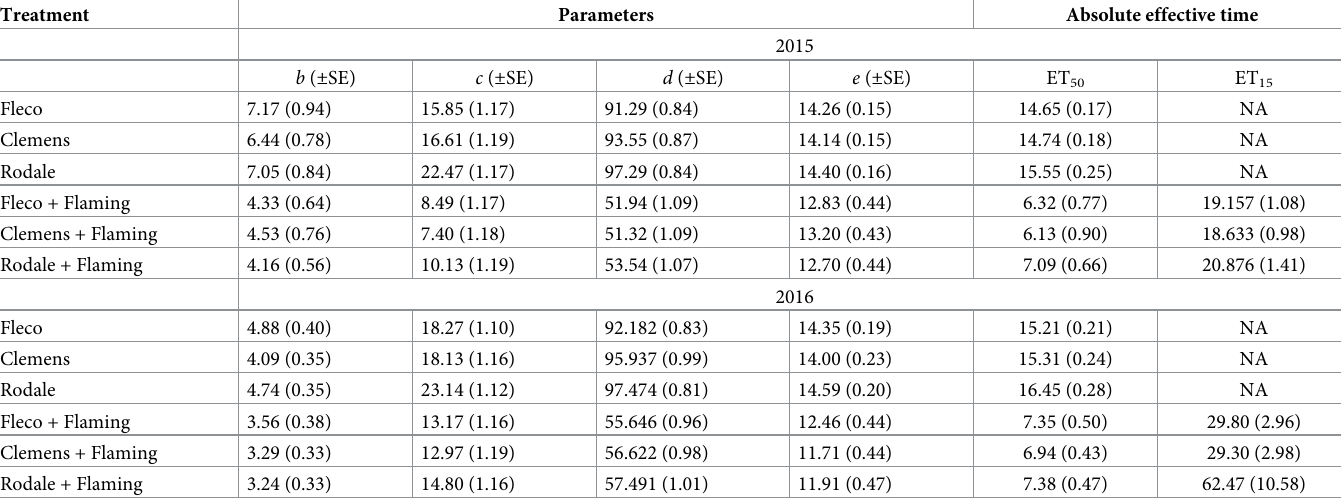
b is the slope of the function at the inflection point; c is the green cover (%) at the end of the experiment; d is the green cover (%) at 1 day after termination; e is the time (days) corresponding to 50% green cover between the upper and the lower limits of the curve (at the inflection point); SE is the standard error. Residual standard error: 2.29 and 2.02 for 2015 and 2016, respectively. Degrees of freedom: 96. ET 50 is the absolute effective time (days) needed to achieve 50% of green cover. ET 15 is the effective time (days) needed to achieve15% of green cover (i.e. 85% of devitalisation of the cover crop). NA: estimation not available when flaming was used in combination with rollers, the percentage of green cover one day after the termination was 1.8-fold and 1.7-fold statistically lower (95% CIs: 36.66, 42.04; 39.49, 44.96; 41.09, 46.40 for the Fleco, Clemens and Rodale roller, respectively, in 2015, and 34.06, 39.02; 36.58, 42.05; 37.45, 42.52, for the Fleco, Clemens and Rodale roller, respectively, in 2016) compared to that of the rollers used alone. At the lower limit of the curve (i.e. final per-